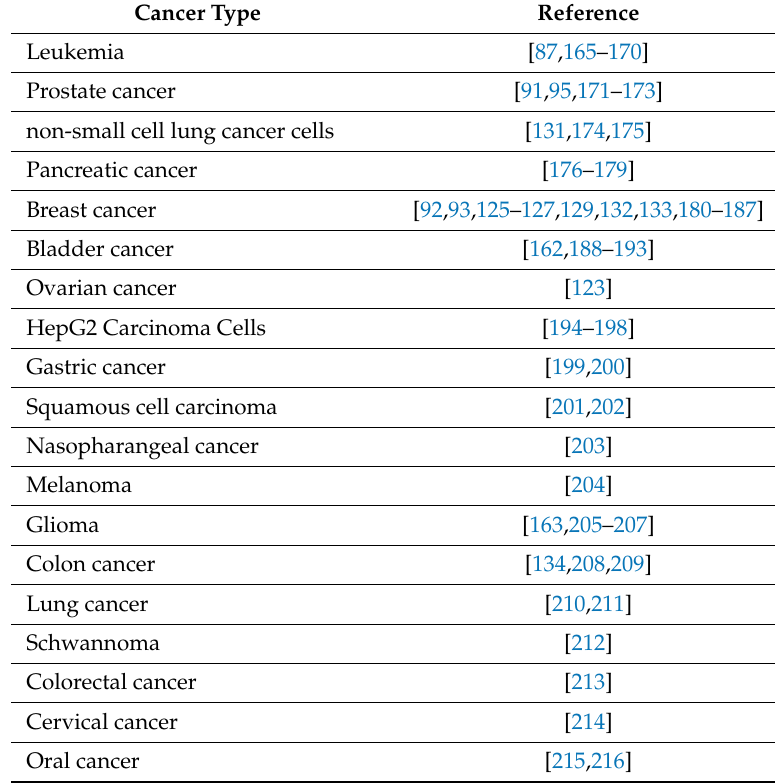
Table 6. Sulphoraphane Applications in Cancer